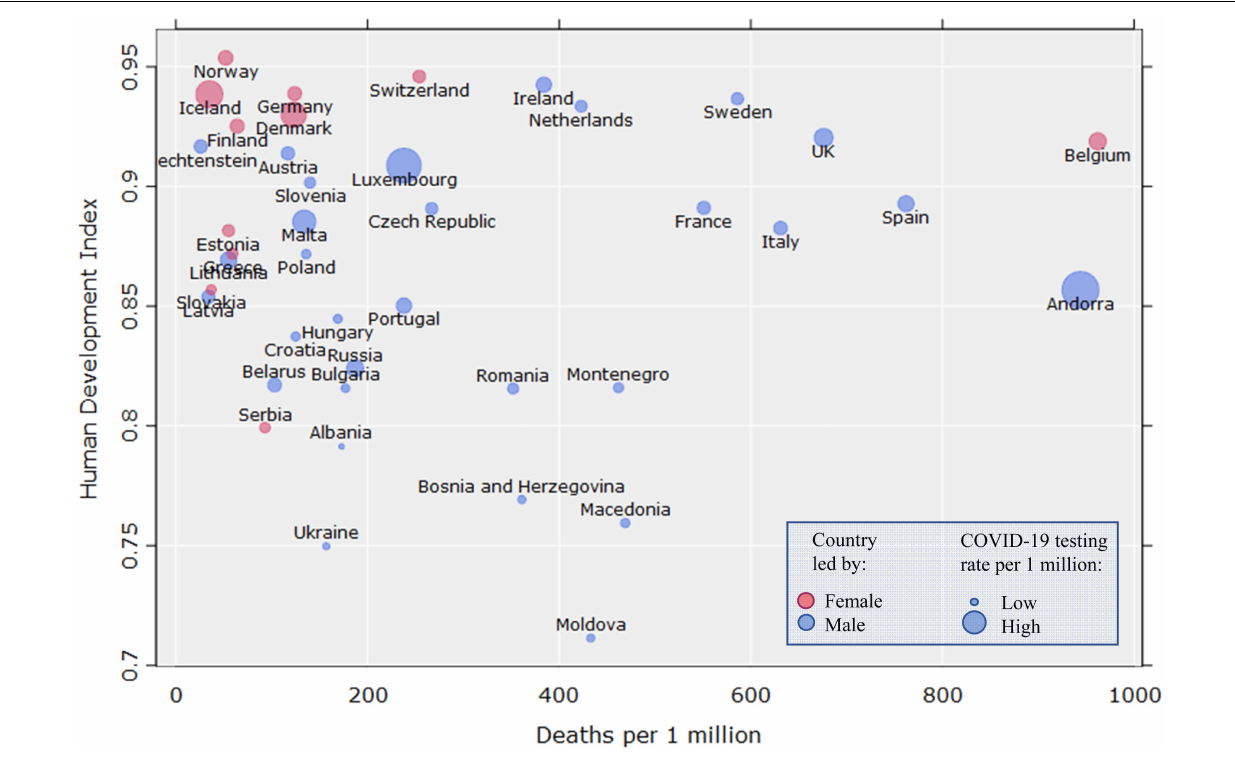
FIGURE 3 | COVID-19 deaths per 1 million in relation to the Human Development Index in European countries ( n = 41, r s = –0.07). Data points are colored according to the sex/gender of the country leader, and scaled to COVID-19 tests per 1